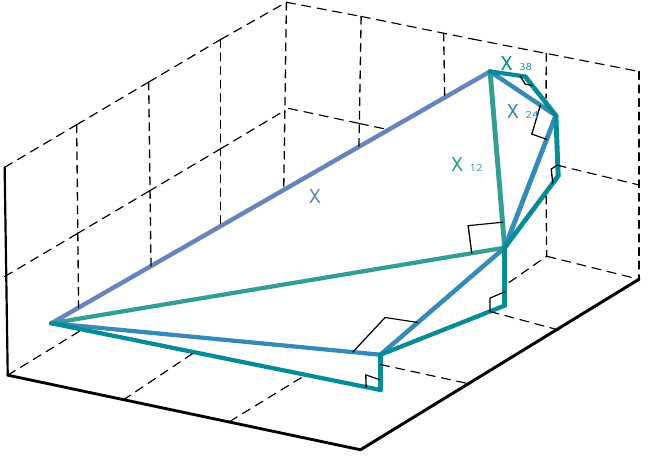
Figure 3. The geometry of ID-PCA.